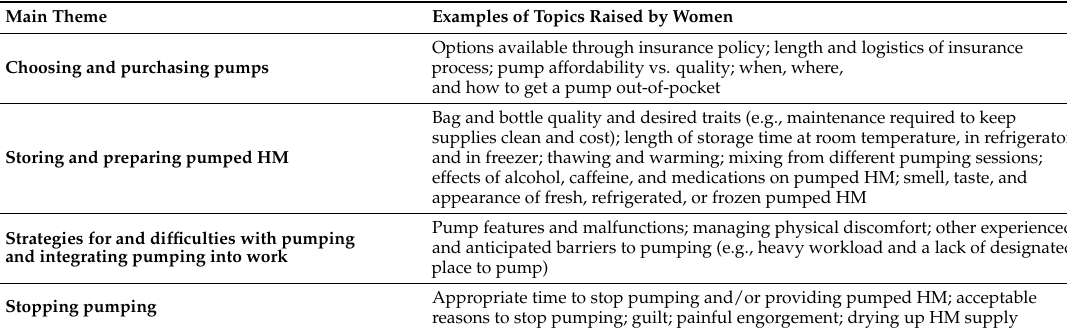
Table 2. Themes and